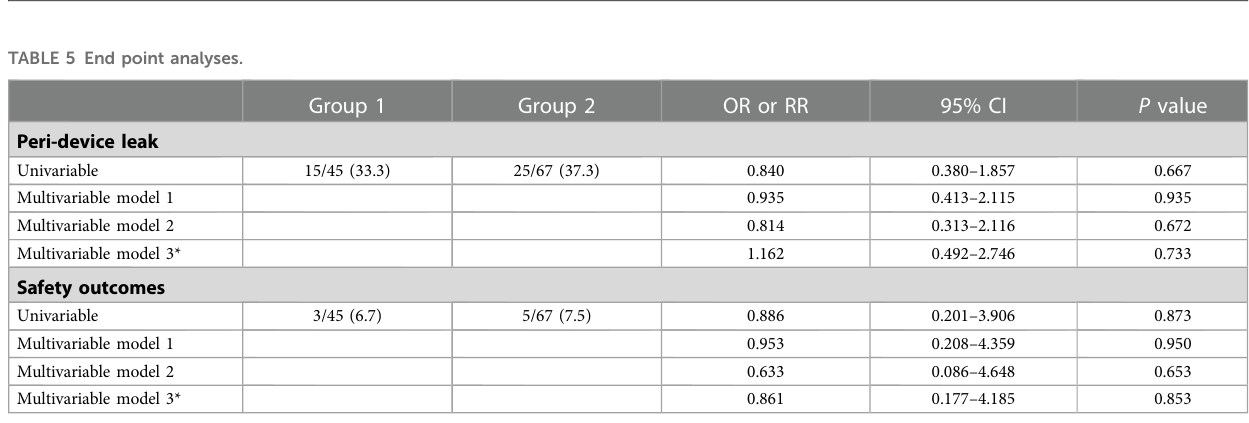
safety outcomes ( Table 5 ). Propensity score matching analysis